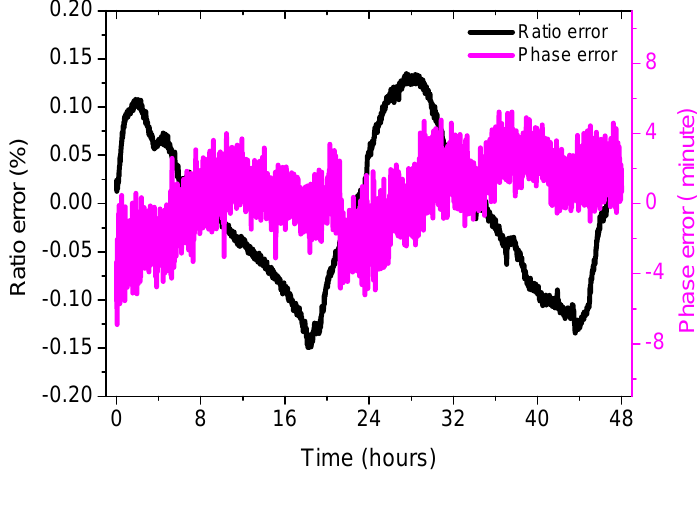
Figure 7. Ratio error and phase error versus time at a rated voltage of 10 kV